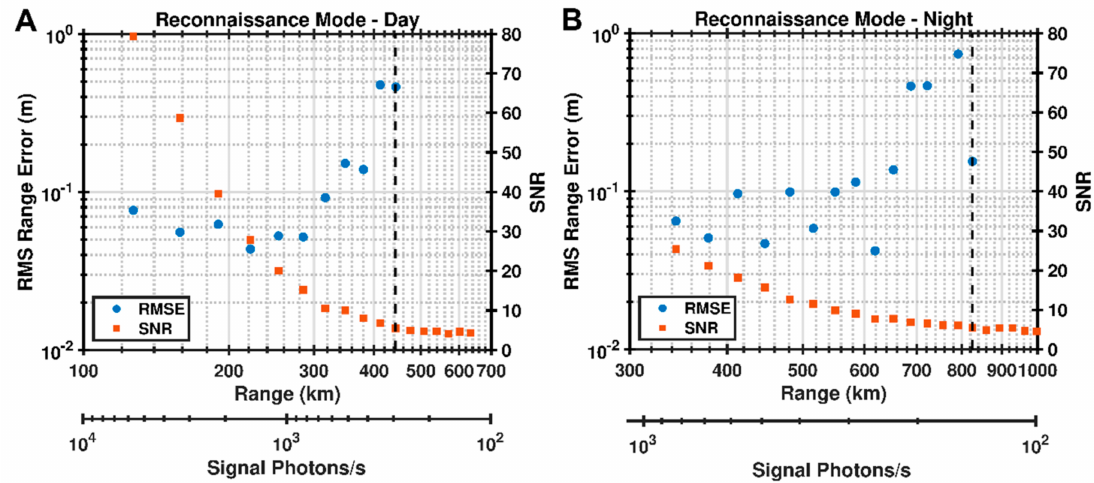
Figure 10. Simulation results of the root mean squared ranging error and mean SNR as a function of target range for the SALi Mapping mode under ( A ) daytime and ( B ) nighttime conditions. Each point corresponds to five independent simulations. The exact range for each simulation was generated via a base range ( ex. 100 km) and an additional randomly generated range between − 1 and 1 m. The signal photon rates were calculated from the mean-removed cross-correlation peak, the laser pulse rate, and the integration time. The simulation assumed a flat surface (no range spreading). The vertical dotted line corresponds to the maximum range.